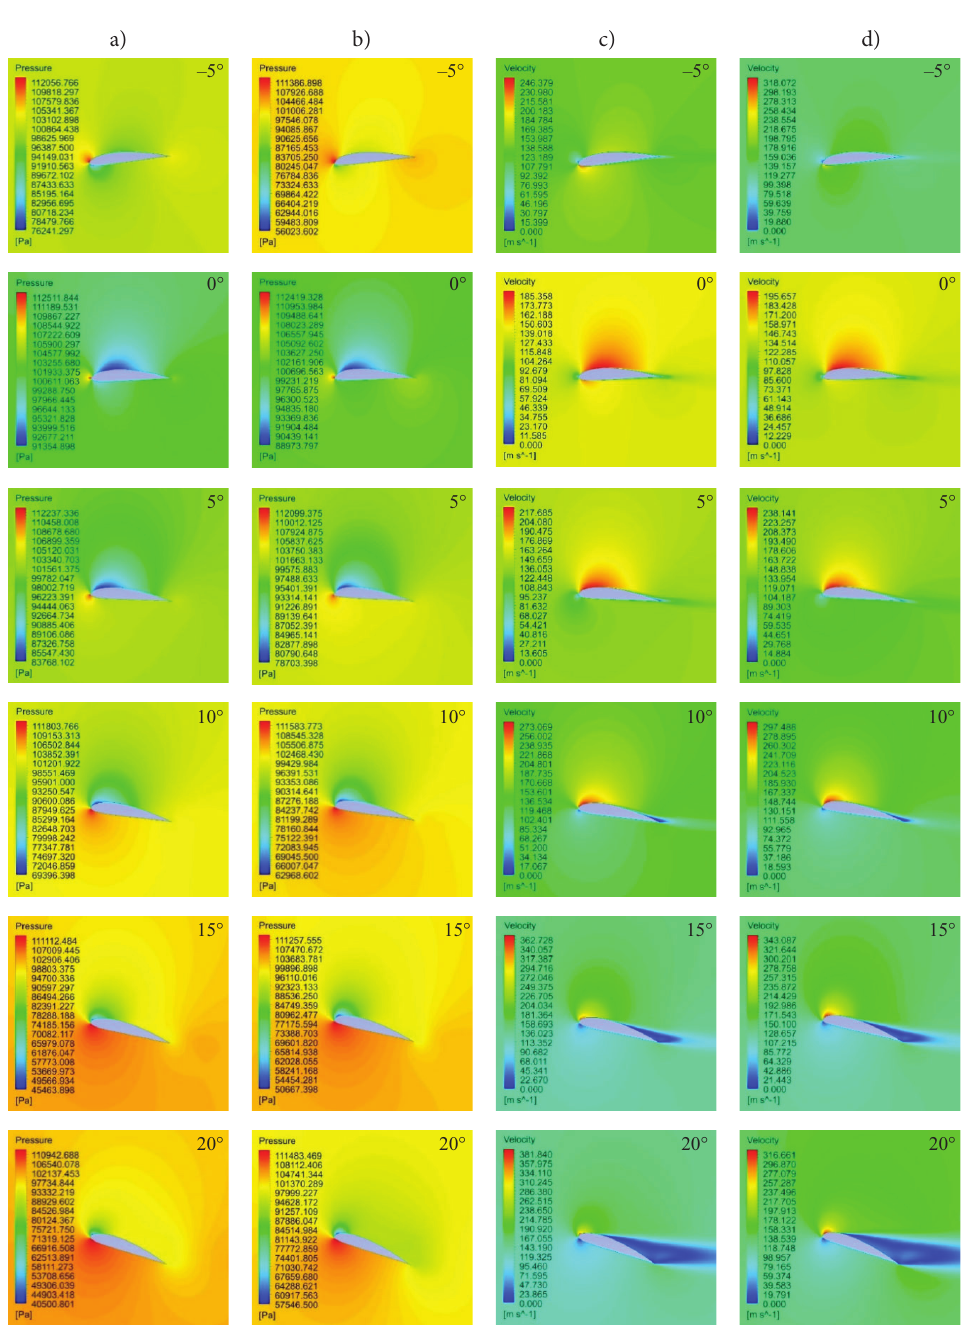
Figure 4. Pressure and velocity contours around the: a, c) original and b, d) optimized airfoils at the different angle of